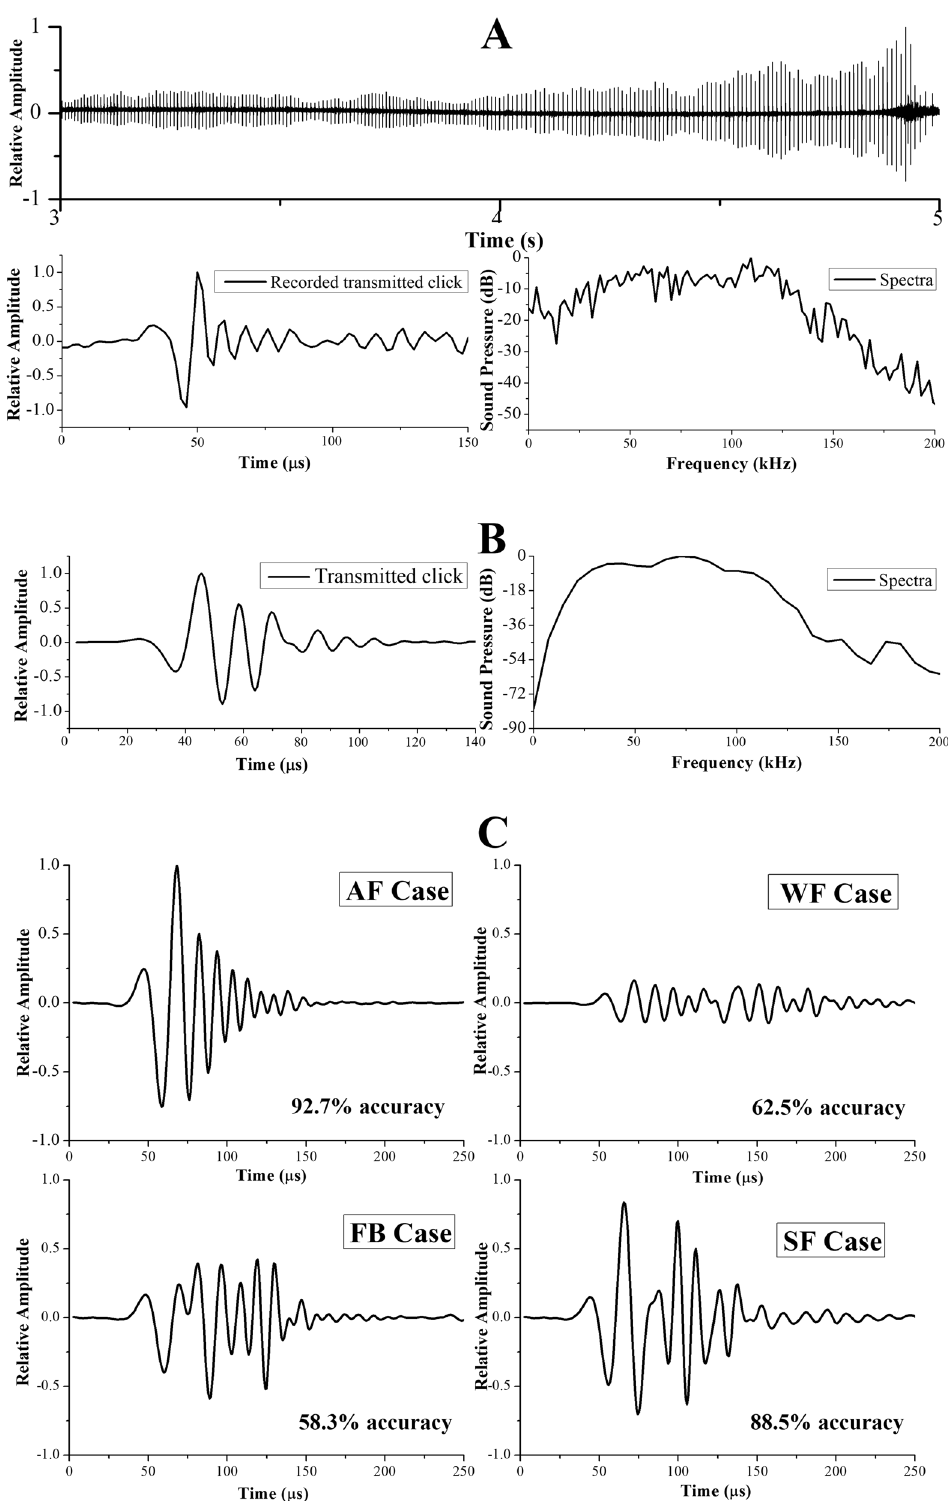
Figure 3. The recorded signals and simulated signals. ( A ) The waveform and corresponding spectra of a single transmitted click from a click train recorded in the AF trial. ( B ) The waveform and corresponding transmitted click at the instant of T1 from the model. Comparisons of simulated receiving echo waveforms ( C ) and frequency spectra ( D ) of four cases. The simulated signal data for each case is provided in